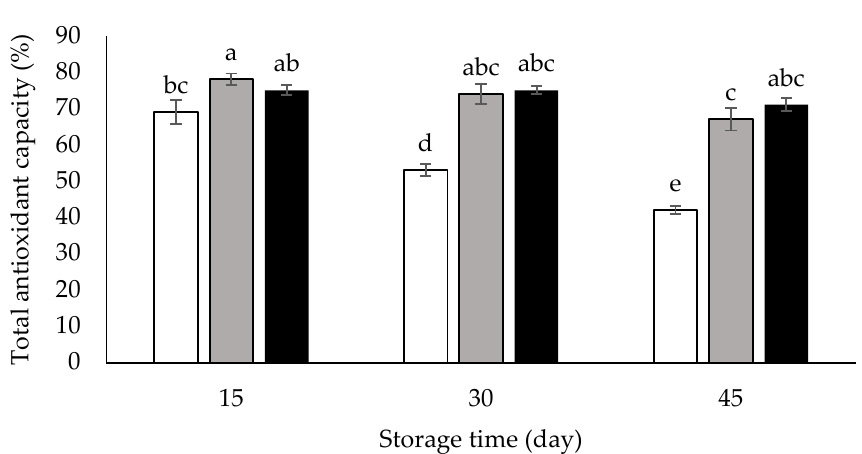
Figure 8. The effect of different levels of postharvest treatment of L-arginine on the total antioxidant capacity of persimmon cv. “Karaj” fruits during cold storage (DMRT, p ≤ 0.05). The values of data are average of n = 3, and bar represents standard error of the means. Different letters above the bars show significant difference at p < 0.05 by Duncan’s multiple range test.